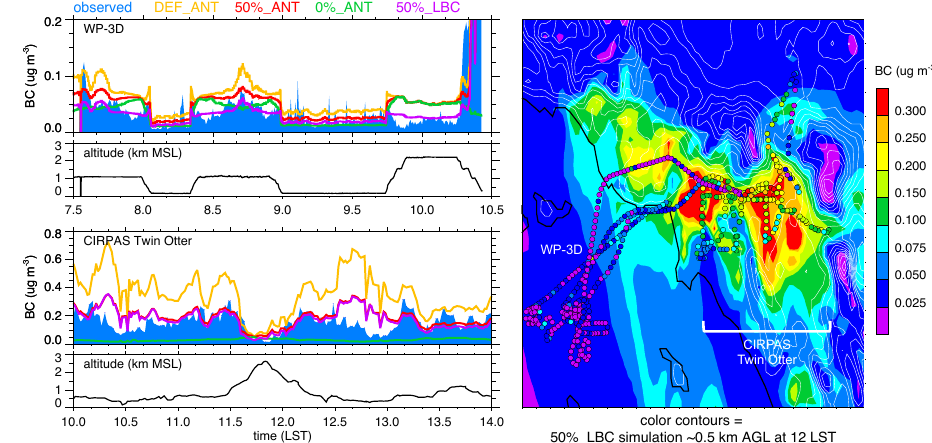
Figure 10. Observed and simulated BC on 21 May 2010 along the WP-3D and CIRPAS Twin Otter flight paths (left panels) and spatial variations in observed BC (right panel). Gray contour lines in right panel denote model topography.